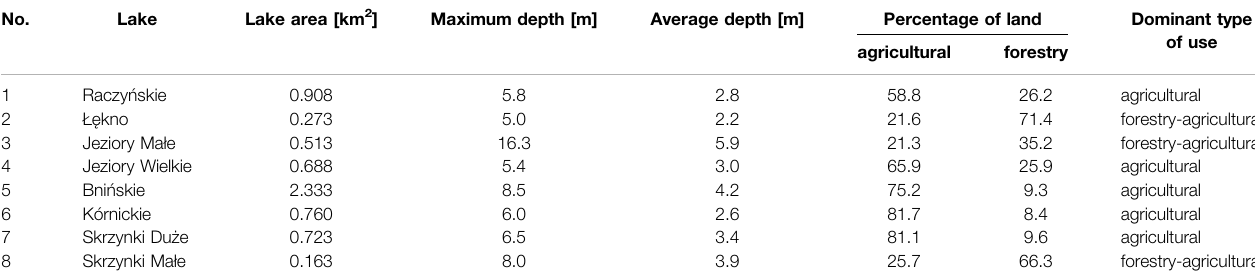
TABLE 1 | Basic characteristics of lakes of the Kórnik-Zaniemyska Gutter (source: Choi ń ski 2006, own research).